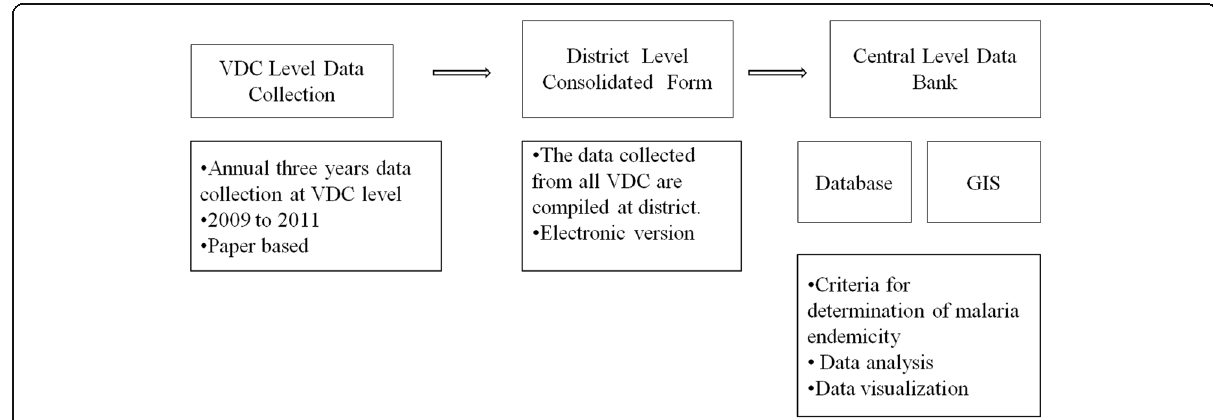
Fig. 2 Basic malaria information flow from VDC to central